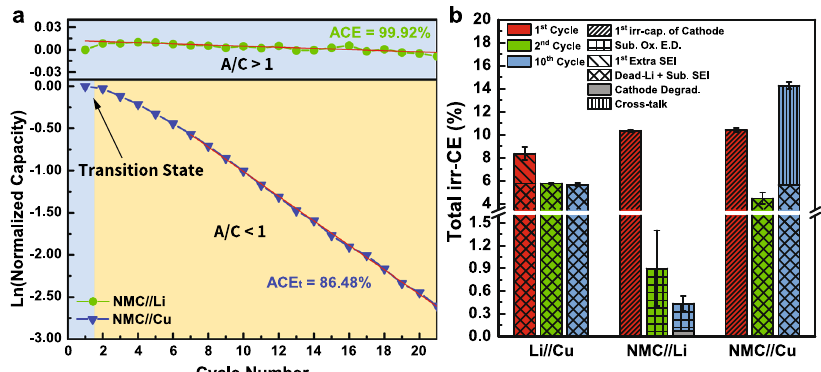
Fig. 4 Results obtained from integrated protocol using 1 M LiPF 6 in EC:DEC (1:1) as electrolyte under the current density of 0.2 mA cm − 2 . a Normalized discharge capacity versus cycle number of NMC/Li and NMC/Cu cells. b irreversible CE comparison of Li/Cu, NMC/Li, and NMC/Cu cells. Error bars represent standard deviation, n = 3 independent replicates. The capacity retention comparison of NMC/Li and NMC/Cu cells are shown in Supplementary Fig. 8a.